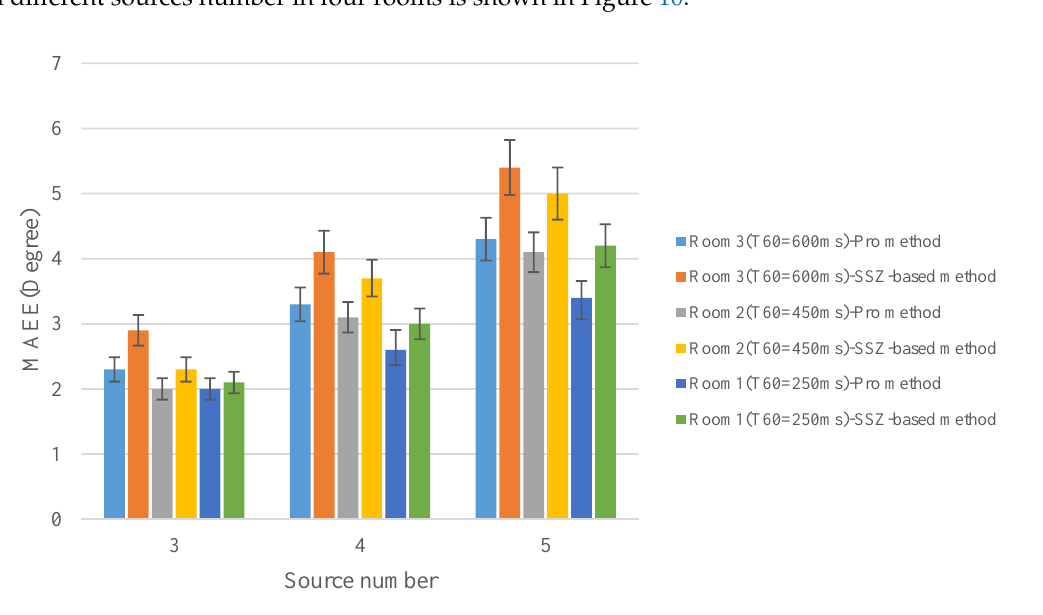
Figure 10. MAEE versus sound sources number in reverberant condition.